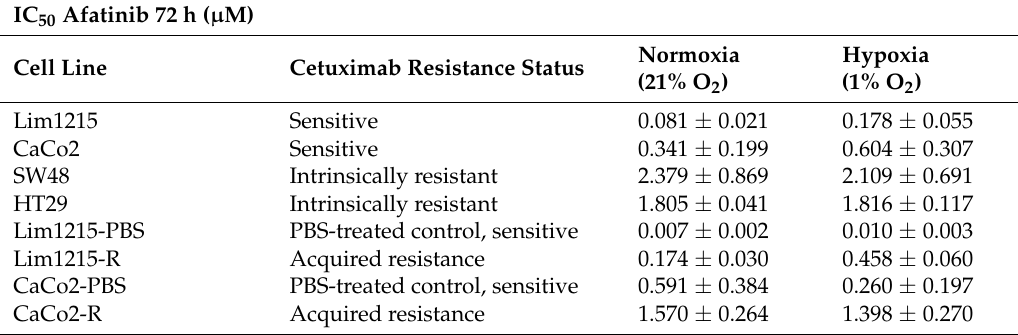
Figure 4. Cytotoxicity of afatinib in CRC cell lines with different cetuximab sensitivities. ( a ) Dose–response curves for cetuximab-sensitive and intrinsically-resistant CRC cell lines. ( b ) Dose–response curves for acquired cetuximab-resistant and corresponding isogenic cetuximab-sensitive CRC cell lines. Table 1. Half maximal inhibitory concentration (IC 50 ) values and standard errors for CRC cell lines after incubation with afatinib for 72 h under normoxic and hypoxic conditions.